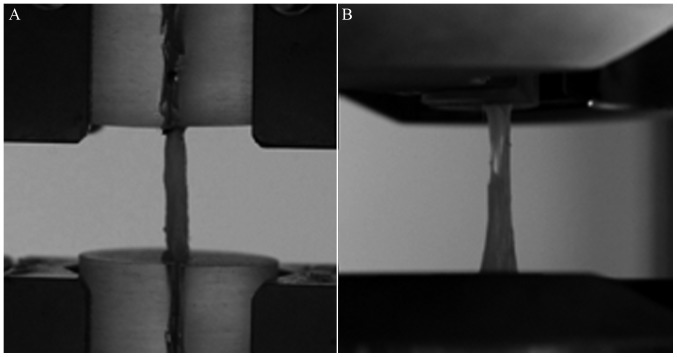
Images showing a tendon at (A) mechanical testing and (B) rupture at maximum load.